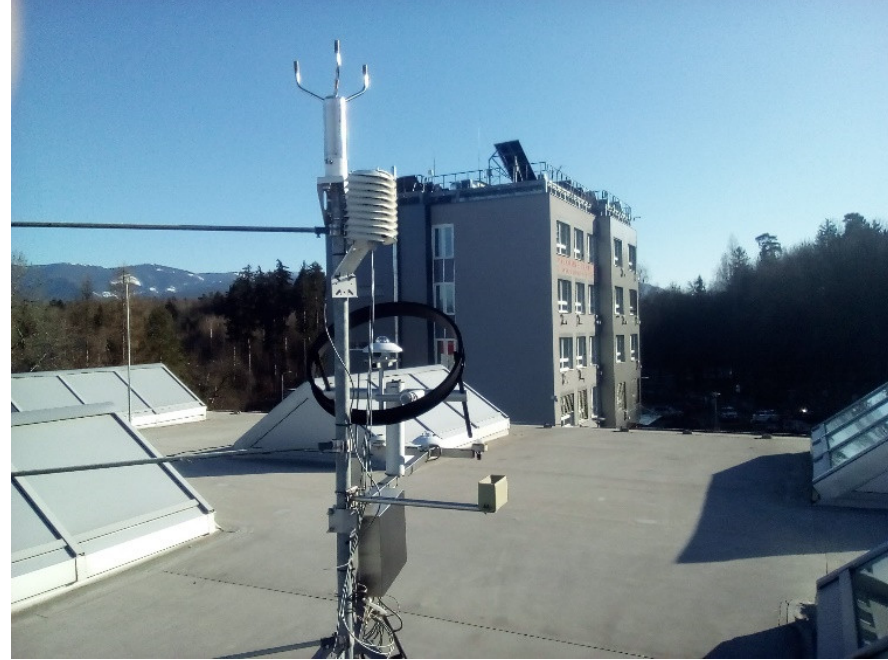
Figure 4. Weather station on the building rooftop near the Research Center from which data on the external environment was used [29].